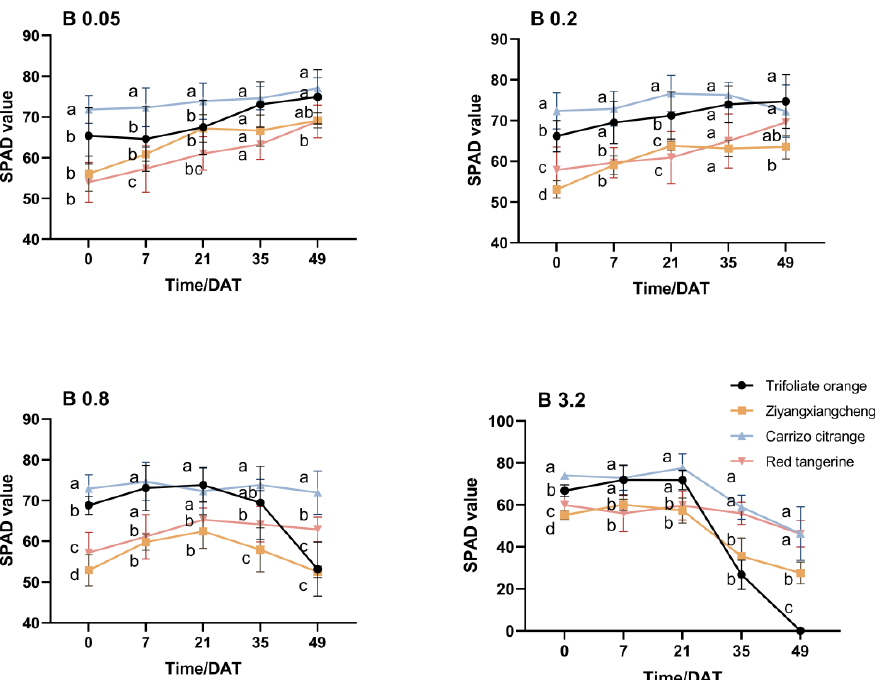
Figure 2. The impact of excess B stress on relative chlorophyll content in the leaves of four citrus rootstock seedlings. Note: B 0.05 served as the control (CK) concentration, and data were compared with Duncan’s multiple range test. Different letters indicate significant differences between rootstocks at the same DAT ( p < 0.05).